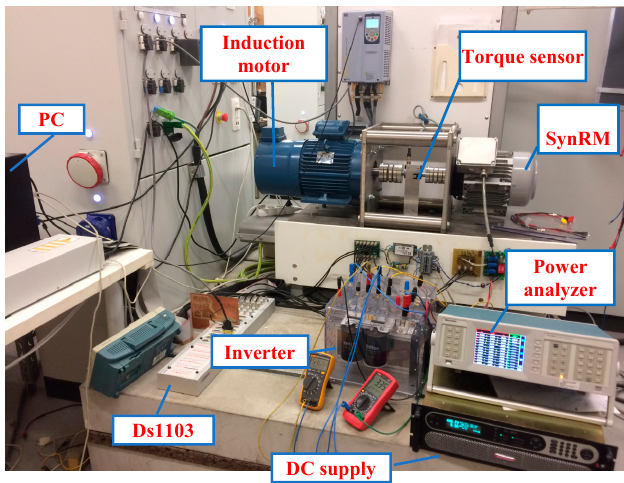
Figure 21. A photograph of the complete experimental setup. PC: personal computer; DC: direct current.